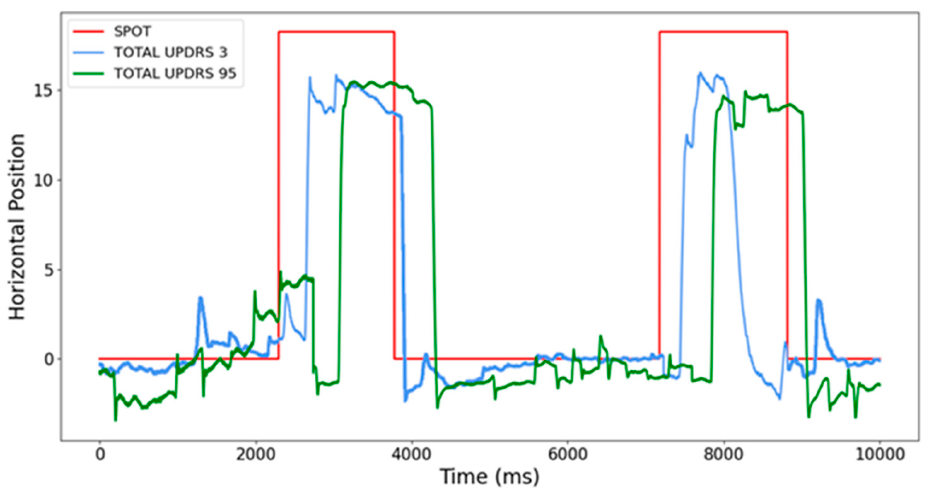
Figure 1. Saccades at various stages of PD. Recordings were performed with different UPDRS measured in clinical conditions under a doctor’s supervision. The red line is related to light spot movements, and the blue and green curves are related to reflexive saccades performed by two different PD patients in different stages of the disease: the blue curve denotes EM at the beginning of the disease, and the green curve at advanced PD. Notice the significant difference in response latencies [11].